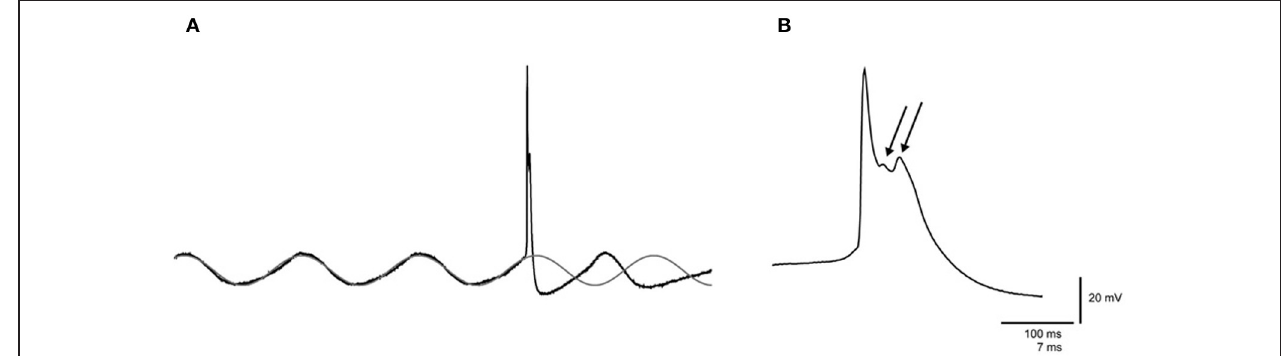
FIGURE 1 | Spontaneous sinusoidal subthreshold oscillations and wavelets of an olivary neuron. (A) Left panel: trace of a spontaneous sinusoidal subthreshold oscillation (SSTO) from an olivary neuron in vivo . The gray trace indicates the sinusoidal fit of the SSTO prior to the occurrence of